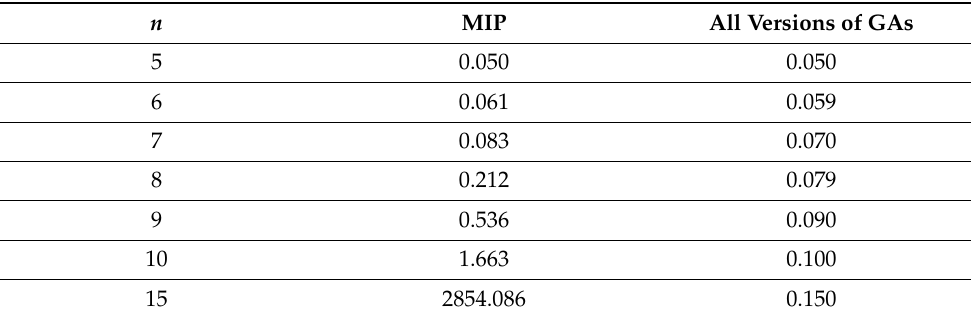
Table 9. The average computational time required by the MIP model and